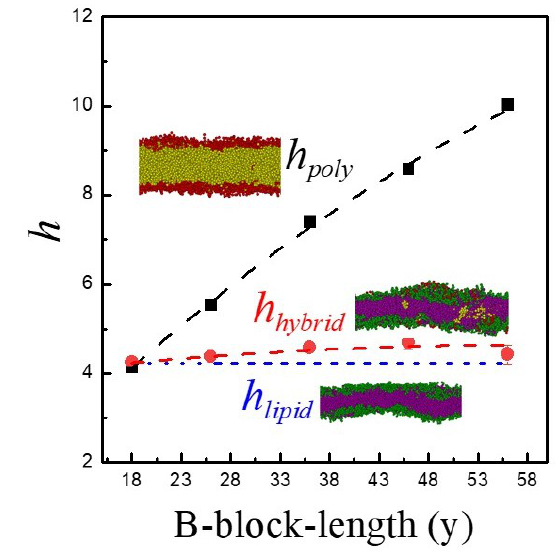
Figure 9. Thickness of hydrophobic layers of pure polymer membrane ( h poly ), pure lipid bilayer ( h lipid ), and hybrid membrane ( h hybrid ). The hybrid membrane is formed by lipids and A 3 B y A 3 with ϕ p = 0.1. Green and purple beads represent lipid head and tail, respectively. Red and yellow beads denote hydrophilic and hydrophobic parts of the copolymer, respectively.